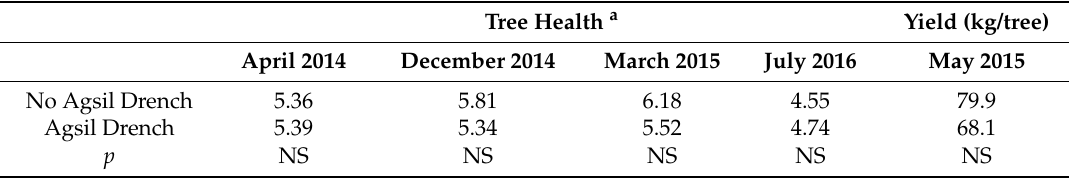
Table 1. Tree health and yield data for 2014–2016 from Agsil amendment trial—Site 1, Childers. Tree Health a Yield (kg/tree)